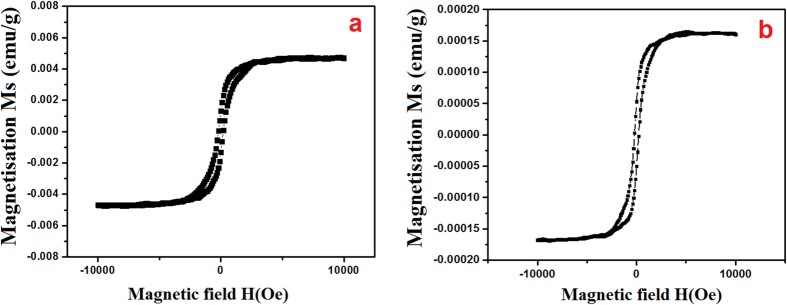
Magnetization curves of (a) CeO2 NPs prepared by the MCM and (b) CeO2 NPs prepared by the CRSGM.